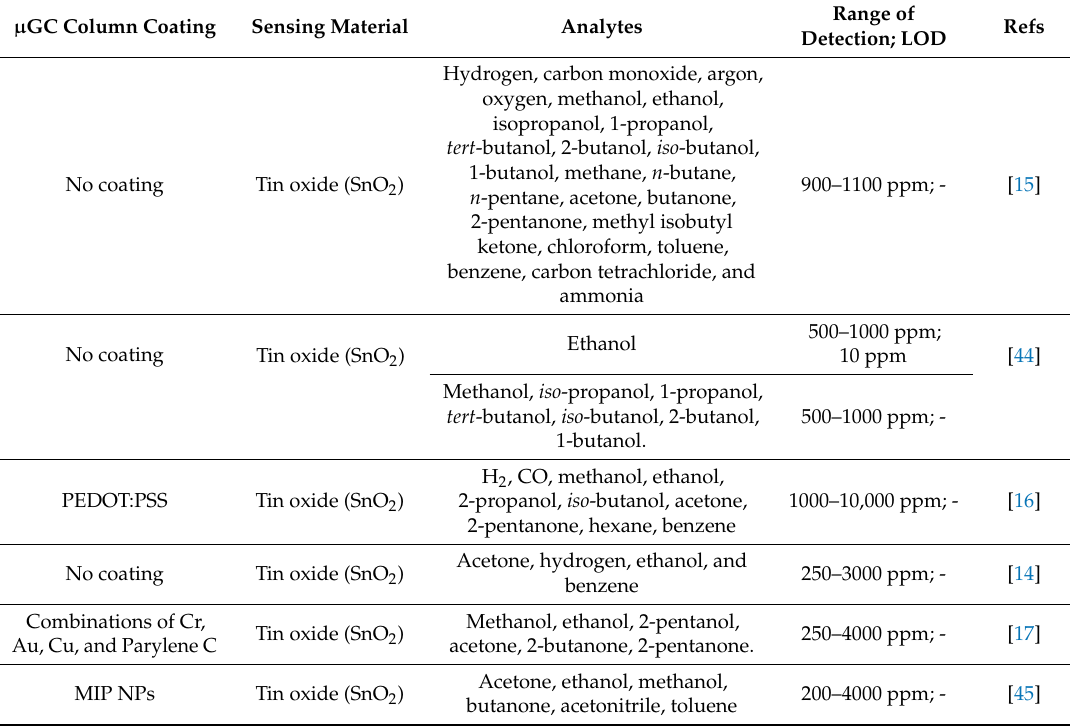
Table 1. Devices coupling a µ GC column and commercially available MOS